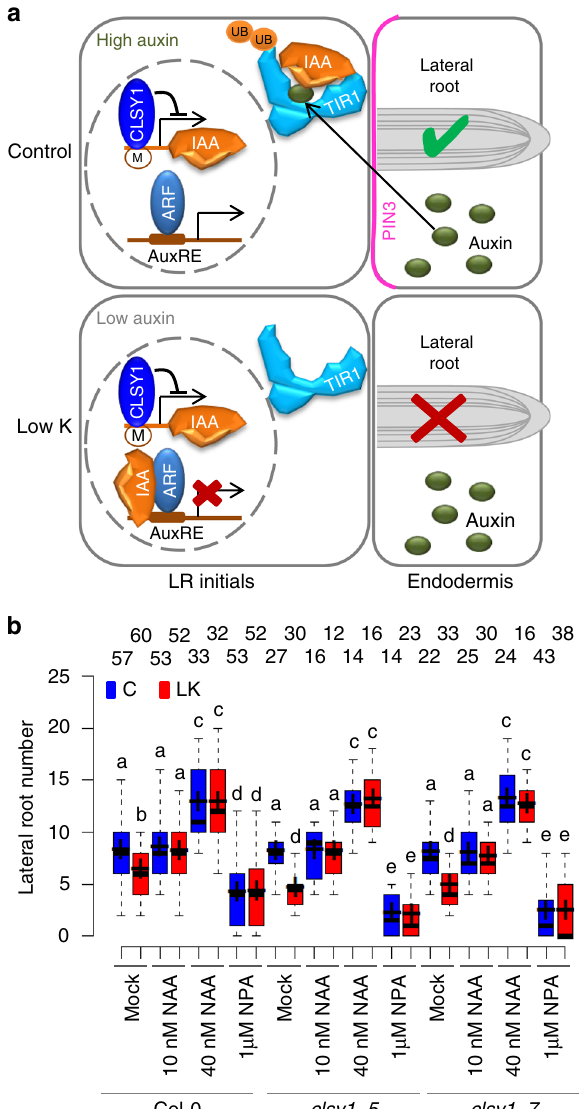
Fig. 6 CLSY1 maintains lateral root development when the auxin pathway is perturbed exogenously. a Schematic summary of the proposed role of CLSY1 at cellular level. In normal conditions, IAA27 is bound by the auxin- TIR1 complex, and targeted for degradation, which releases IAA-inhibition of ARFs, and promotes LR development. When this pathway is perturbed, for example by reduced auxin re fl ux from PIN3 expressing endodermal cells under low K, LR development depends on transcriptional repression of IAA27, which is mediated by CLSY1 . b Number of lateral roots in Col-0 and clsy1 plants grown under control or low K conditions, in the absence or presence of indicated concentrations of auxin analogue NAA or auxin inhibitor NPA. The number of roots analysed ( n ) is indicated above the box plots. The centre lines of the boxplots correspond to medians and the crosses to the means. The boundaries of the box are the fi rst and third quartiles and whiskers extend to 1.5-fold the interquartile range. Signi fi cant differences at P < 0.05 (one-way ANOVA) are indicated by different letters. The source data of b are provided in a Source Data fi le.